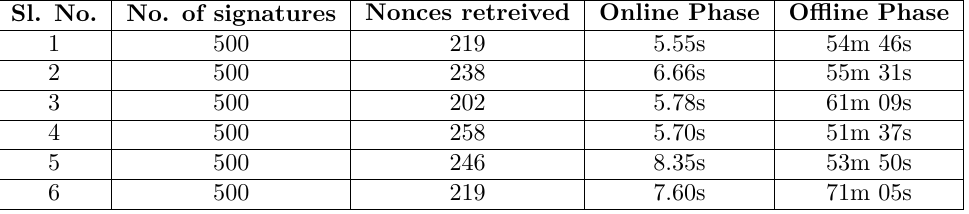
Table 4: Time taken for ECDSA key retrieval from partially leaked nonces. Sl.